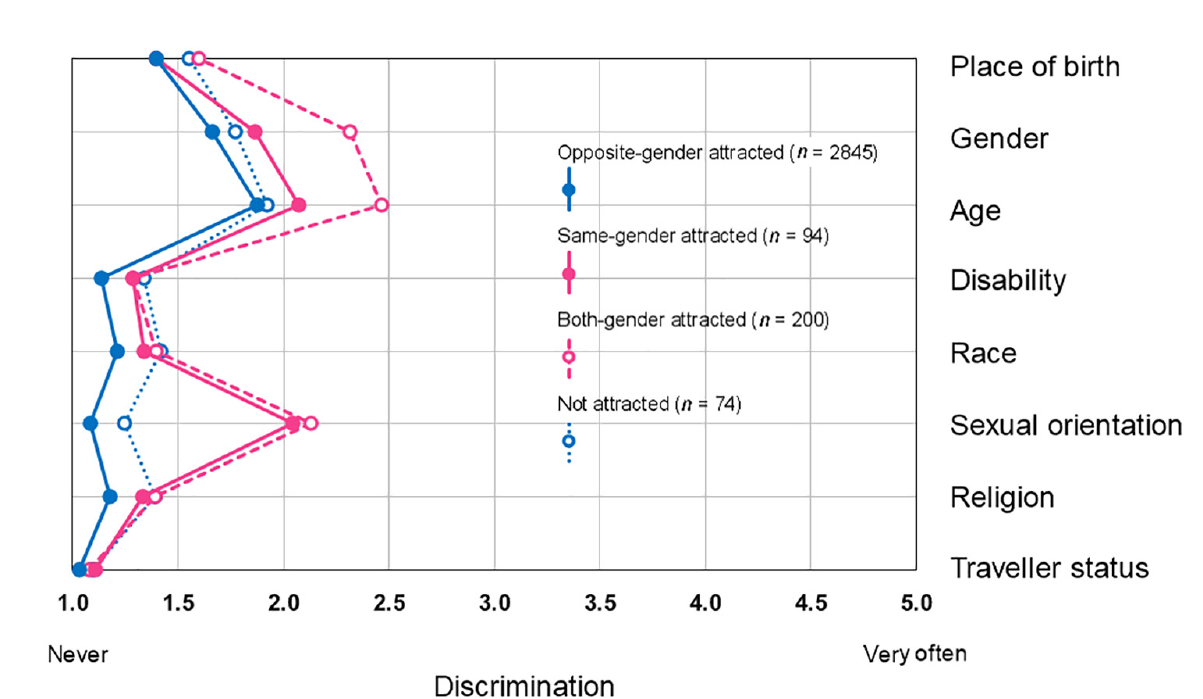
Figure 2. Discrimination profiles in opposite-gender attracted, same-gender attracted, both-gender attracted, and not attracted young people, univariate models ( n =